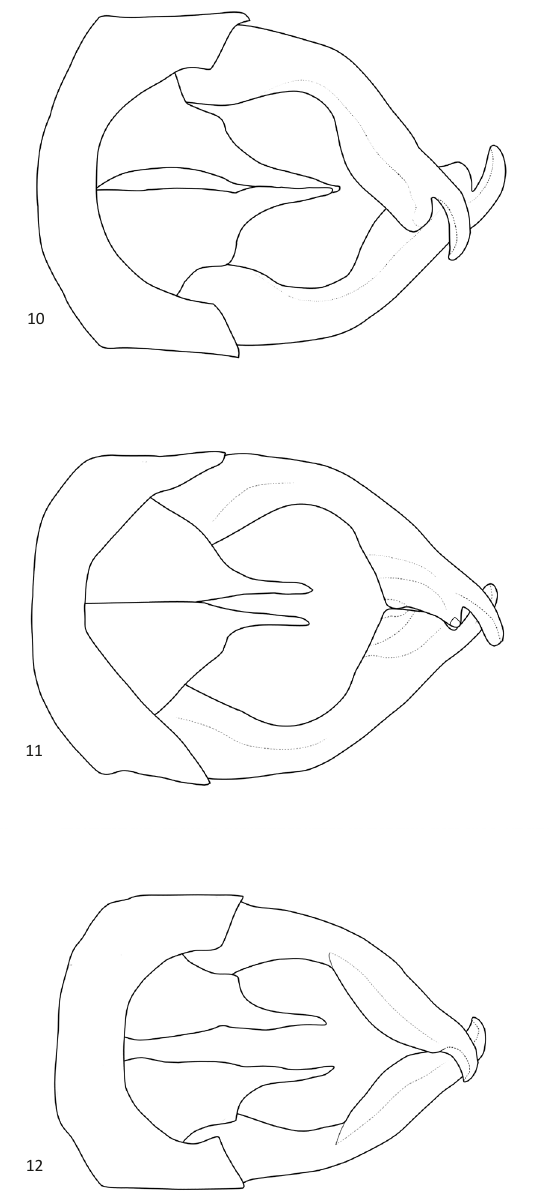
Head: Labium mostly pale, except laterally and around free edge of post mentum. Labrum bluish. Mandible bases mostly pale. Anteclypeus mostly dark brown. Genae mostly black, except immediately adjacent to mandible bases. Postclypeus, frons, vertex and occiput black, with a yellowish streak reaching from each lateral ocellus towards, but not touching, the antenna sockets. Antennae with scape brown, pale at top, pedicel brown, flagellum black. Thorax: Pronotum with anterior lobe brown, dark